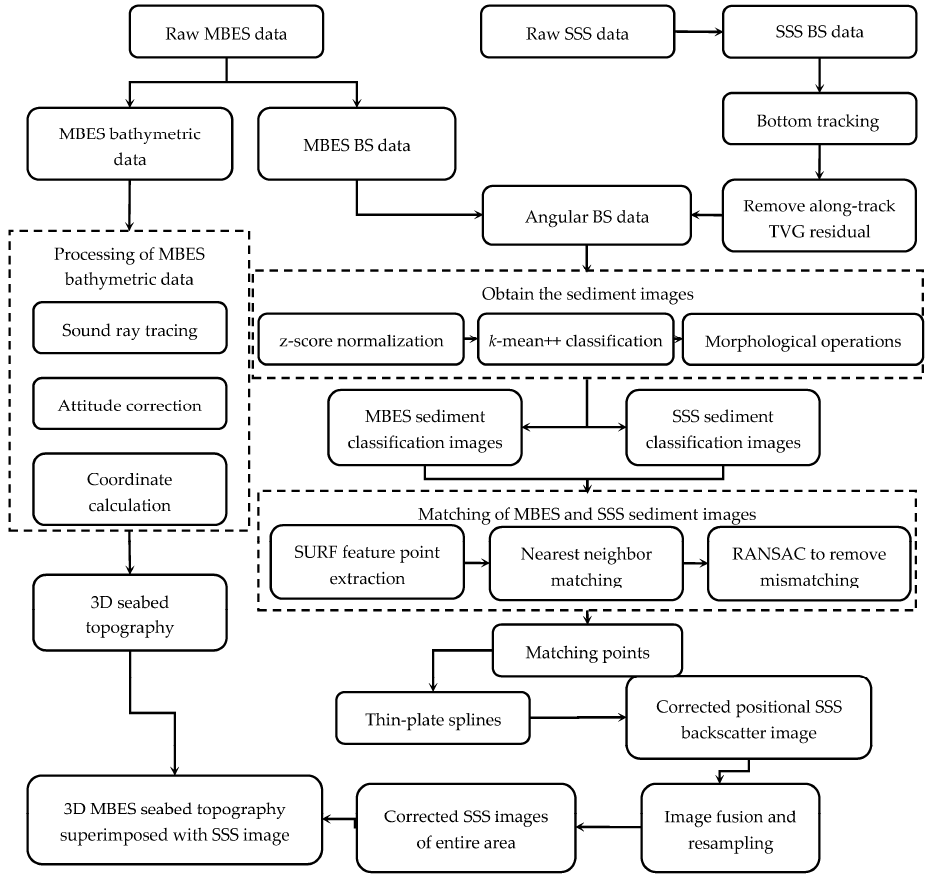
Figure 8. Superimposition of the corrected SSS image and MBES sounding terrain.